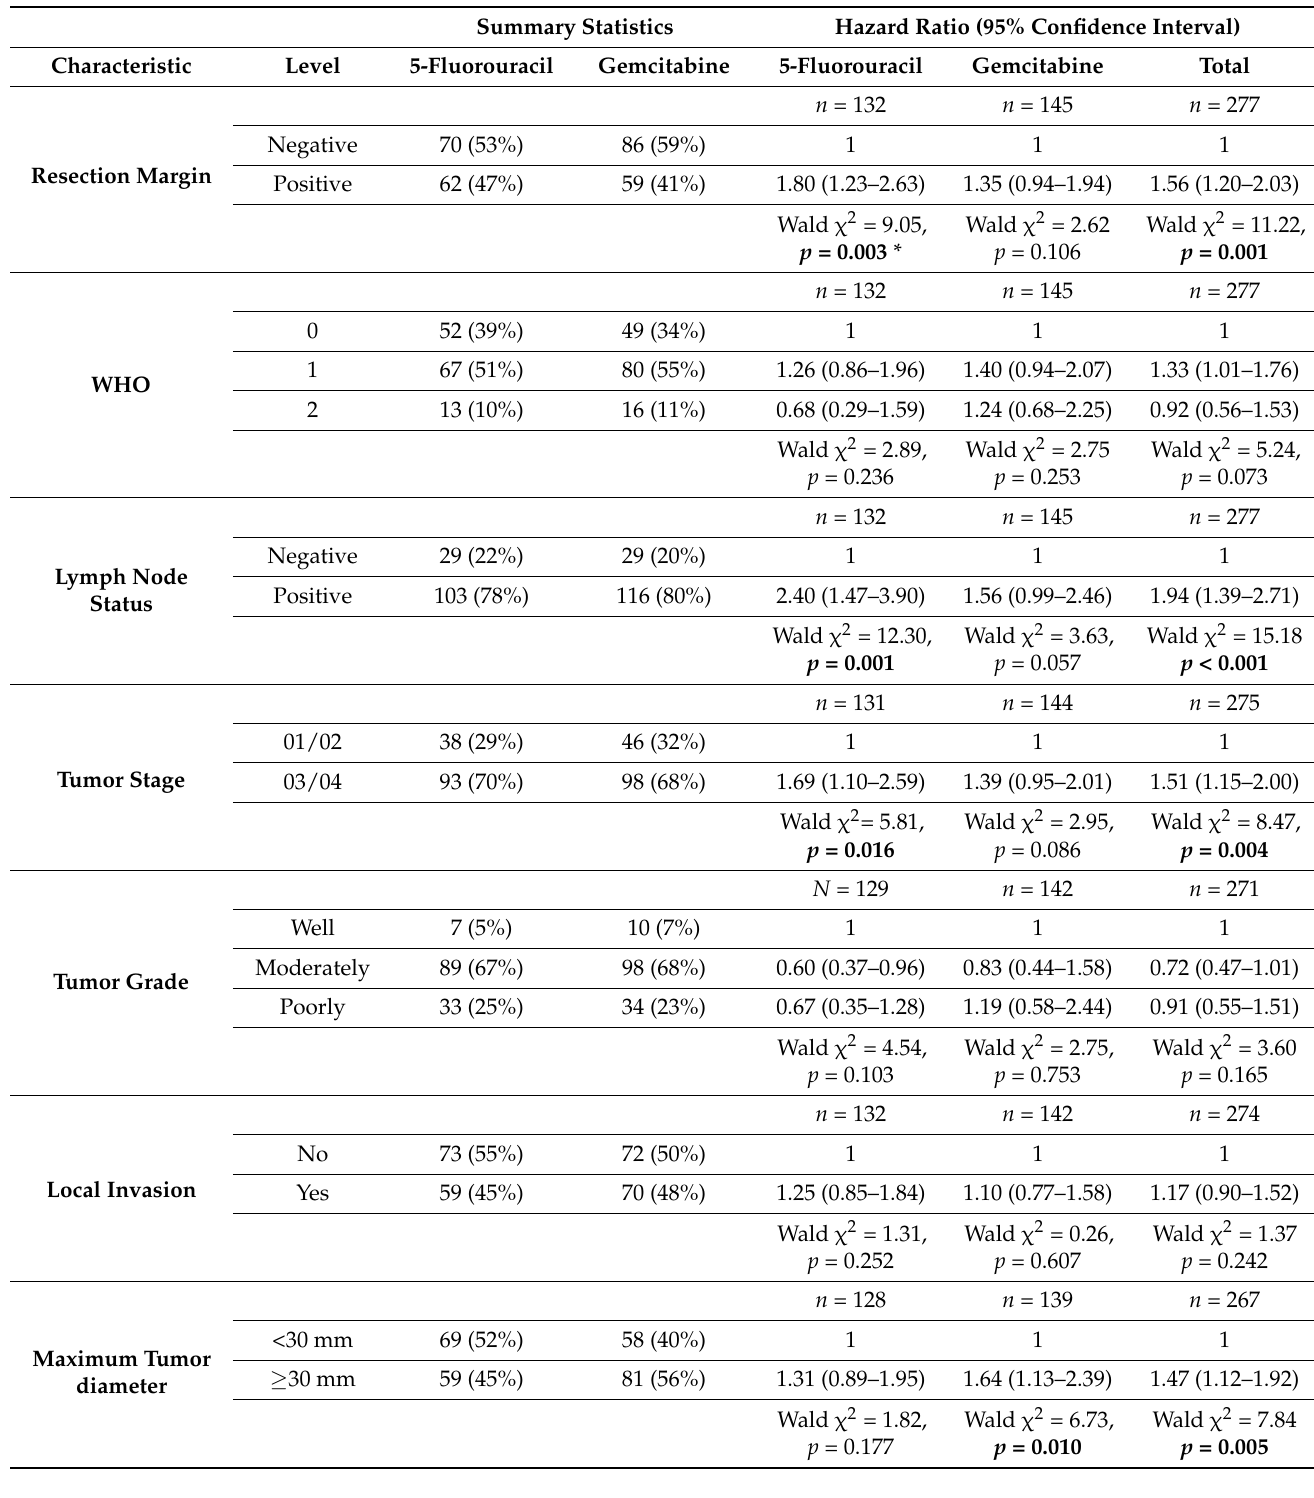
Table 1. Univariate analysis of clinical and pathological factors in the 5-FU and gemcitabine